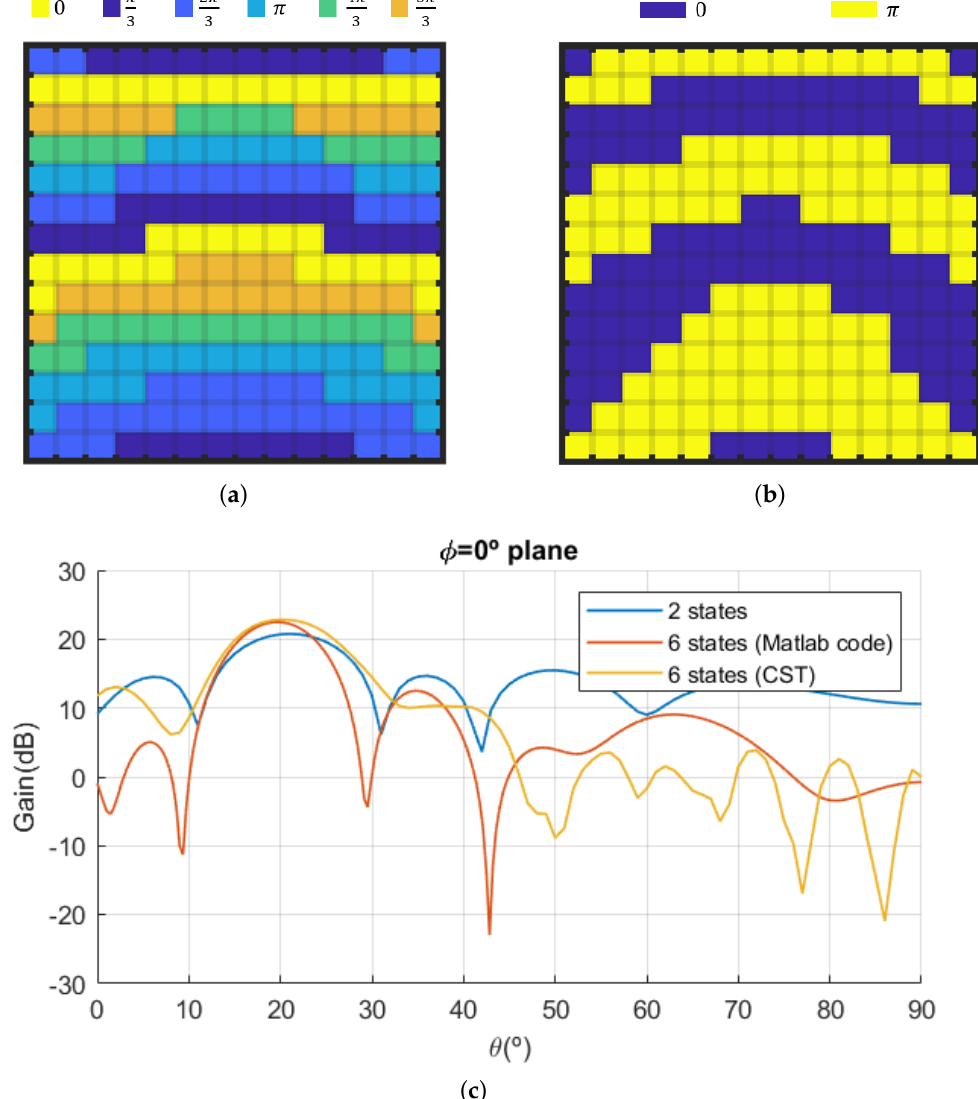
Figure 4. ( a ): Phase arrangement considering six states. ( b ): Phase arrangement considering two states. ( c ): Radiation pattern, beam direction: ( ϕ , θ ) = (0,20) ◦